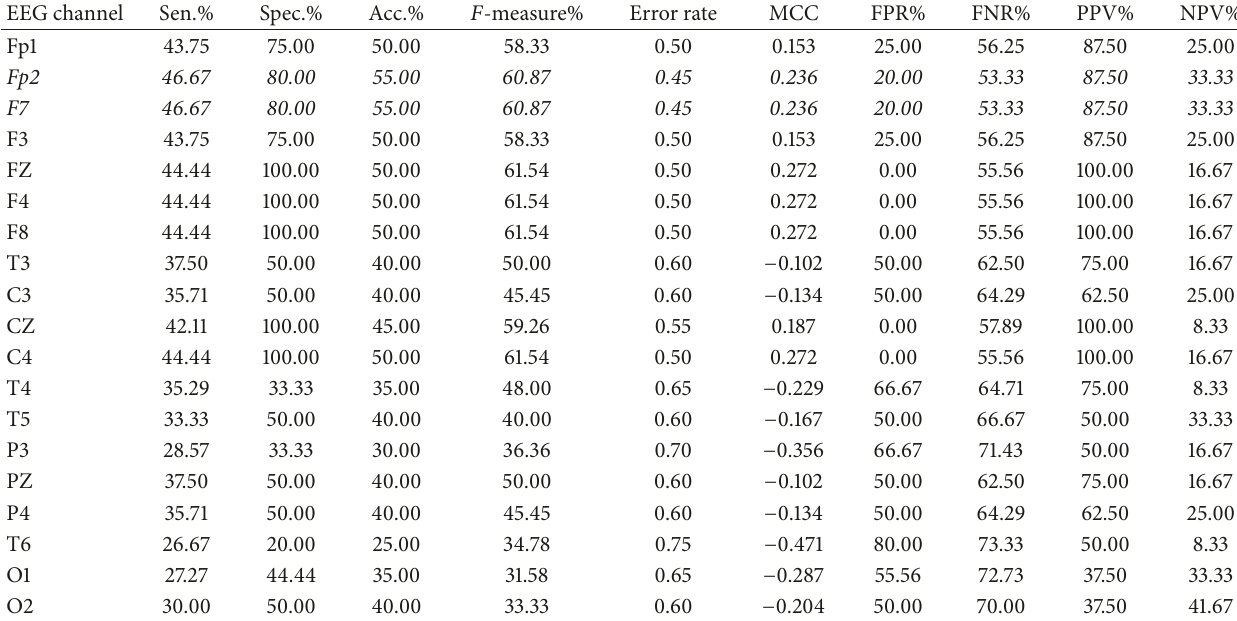
Table 1: TsEn performance for whole EEG record.